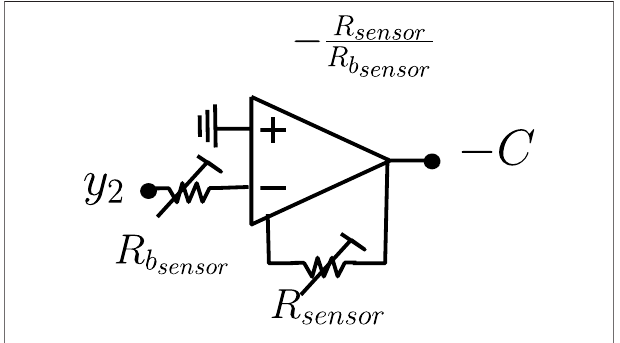
FIGURE5| Schematic circuit proposal forworkingwithalargerrangeof biological sample